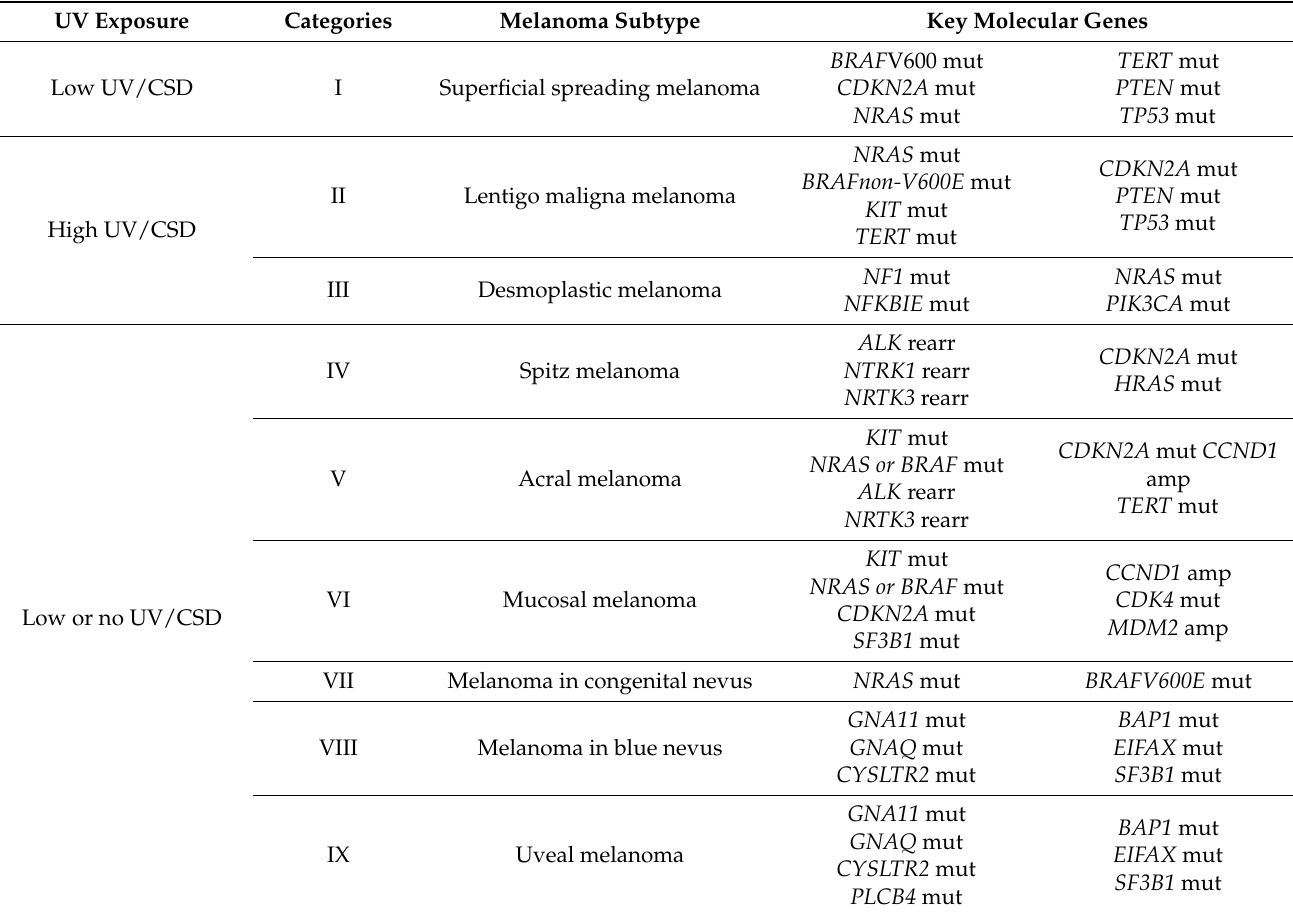
Table 1. The classification of melanomas (modified from 2018 World Health Organization Classification).